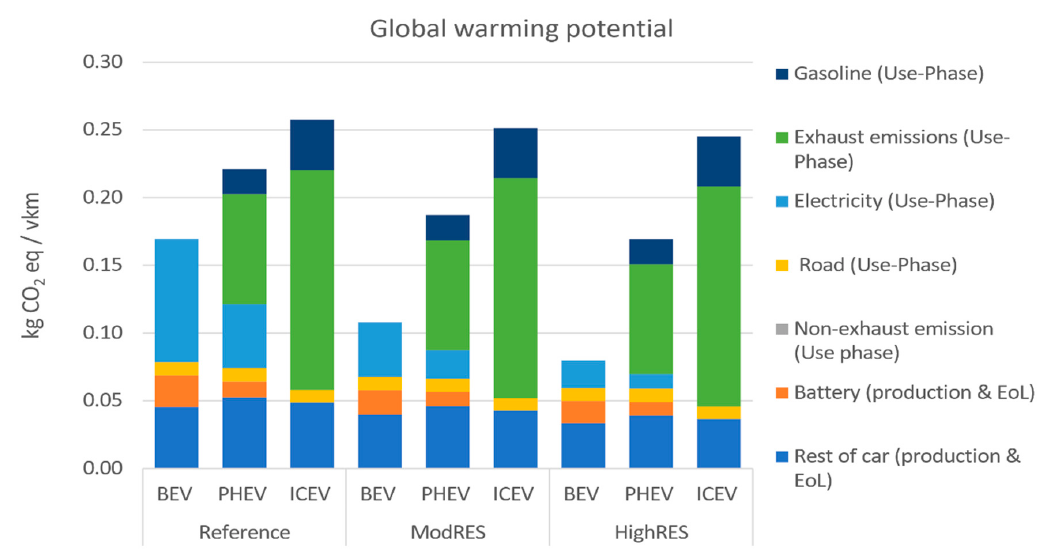
Figure 5. Potential GWP for driving 1 km in reference, ModRES & HighRES. Each bar is divided into seven categories: gasoline (use-phase) refers to impacts along gasoline production chain; exhaust emissions (use-phase) refer to impacts from burning gasoline; electricity (use-phase) refers to impacts along production chains of charging electricity; road (use-phase) refers to impacts from road production and maintenance; non-exhaust emissions (use-phase) refer to impacts from brake and tire wear; battery (production and EoL) refers to impacts along battery production and EoL treatment; and rest of car (production and EoL) refers to impacts along production, maintenance and EoL treatment of all vehicle components except battery.